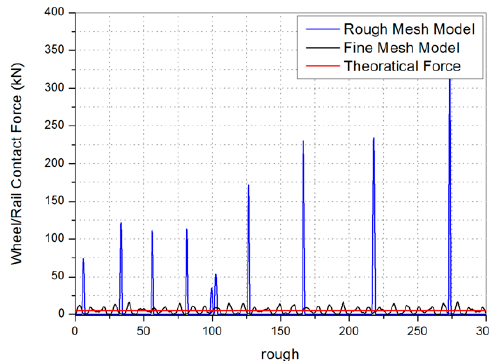
Figure 4. Contact force between wheel and rail.